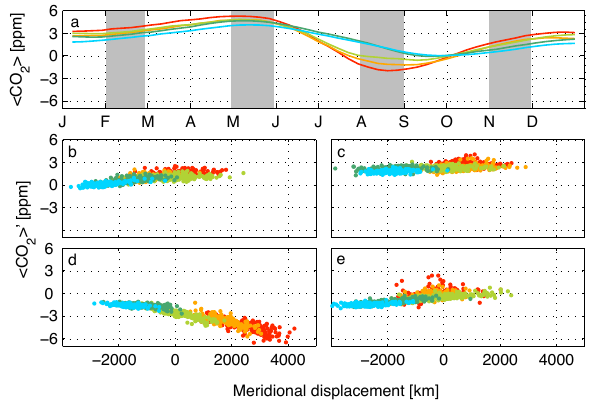
Fig. 12. (a) Detrended h CO 2 i for each of five TCCON sites sam- pled in AM2 driven by zonal-mean NEE. The data at each site have been detrended based on annual mean Southern Hemisphere data. Shaded regions represent the months plotted in (b–e) , which show bandpass filtered h CO 2 i plotted against the meridional displacement relative to Park Falls (46 ◦ N), for four months: (b) February (c) May (d) August (e) November. Colors are the same as Figs. 8 and